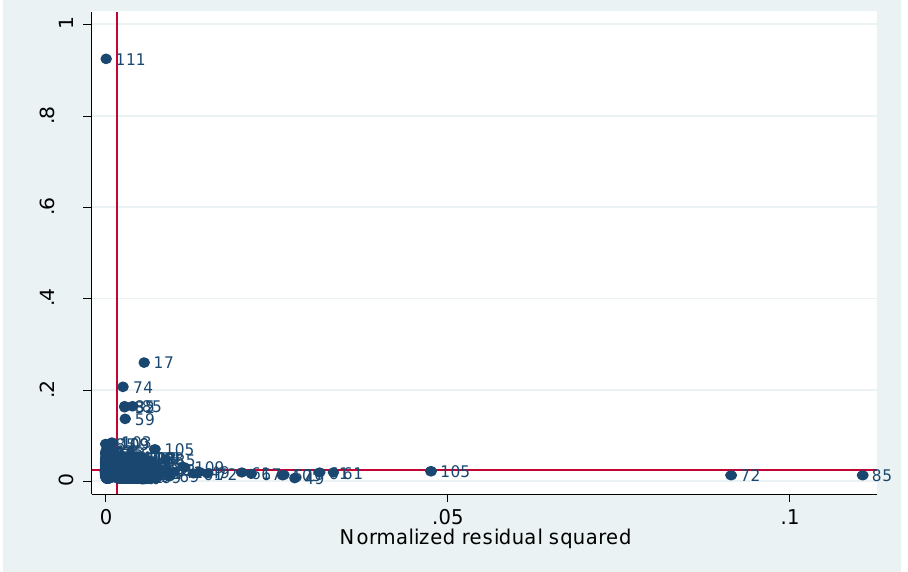
Figure 2. Cook’s Distance Outliers Test.